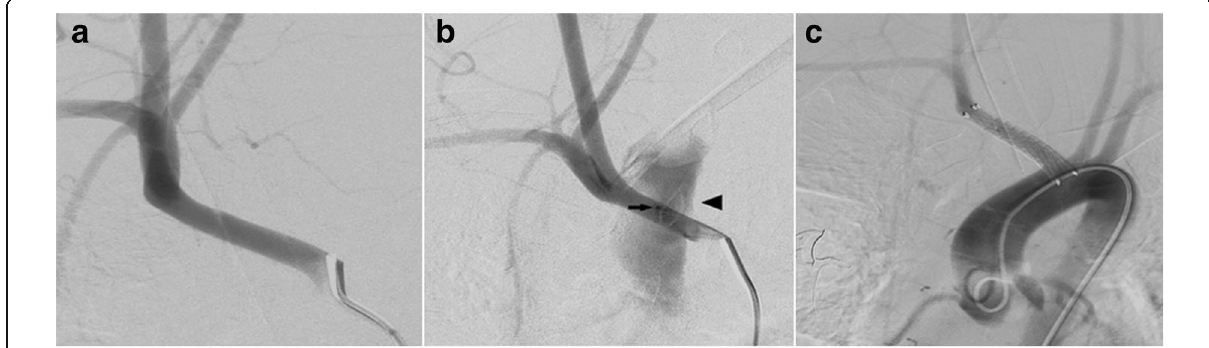
Fig. 1 Diagnostic imaging in a 25-year-old female patient with a tracheoinnominate fistula. DSA of the brachiocephalic artery in posterior-anterior projection with an overinflated tracheal tube showed no bleeding source ( a ). Temporary removal of the tracheal tube and releasing the cuff revealed the contrast medium extravasation from the brachiocephalic artery ’ s posterior wall to the anterior wall of the adjacent trachea, with contrast medium in the trachea (arrow: bleeding spot; arrowhead: contrast medium in the trachea ( b ). The following completion flush DSA run of the aortic arch in a left anterior oblique projection showed the proper wall apposition of the stent-graft, the interruption of the previous extravasation, and the patency of the origins of the right subclavian and both common carotid arteries. The stent-graft was reaching slightly too far proximal into the aortic arch but did not compromise the origin of the left common carotid artery ( c